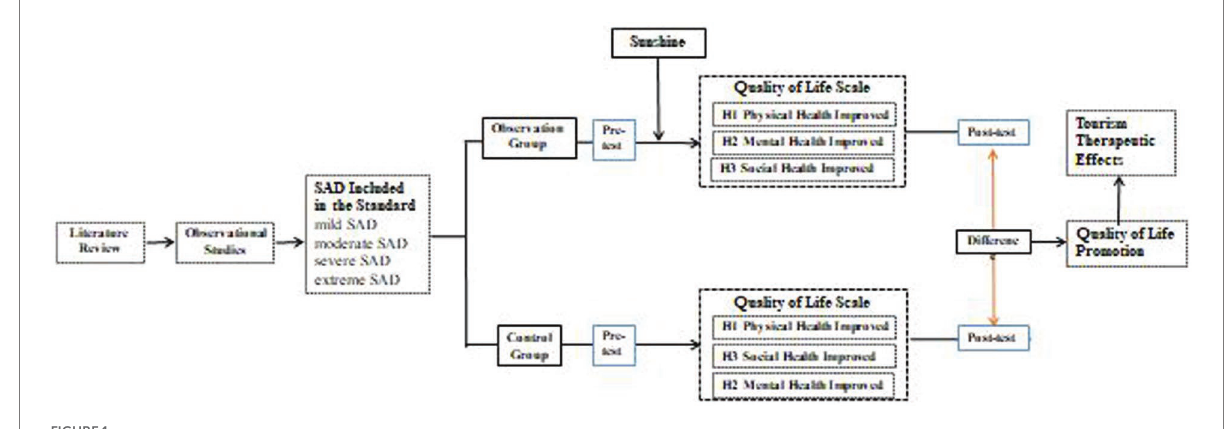
FIGURE 1 The basic framework of the